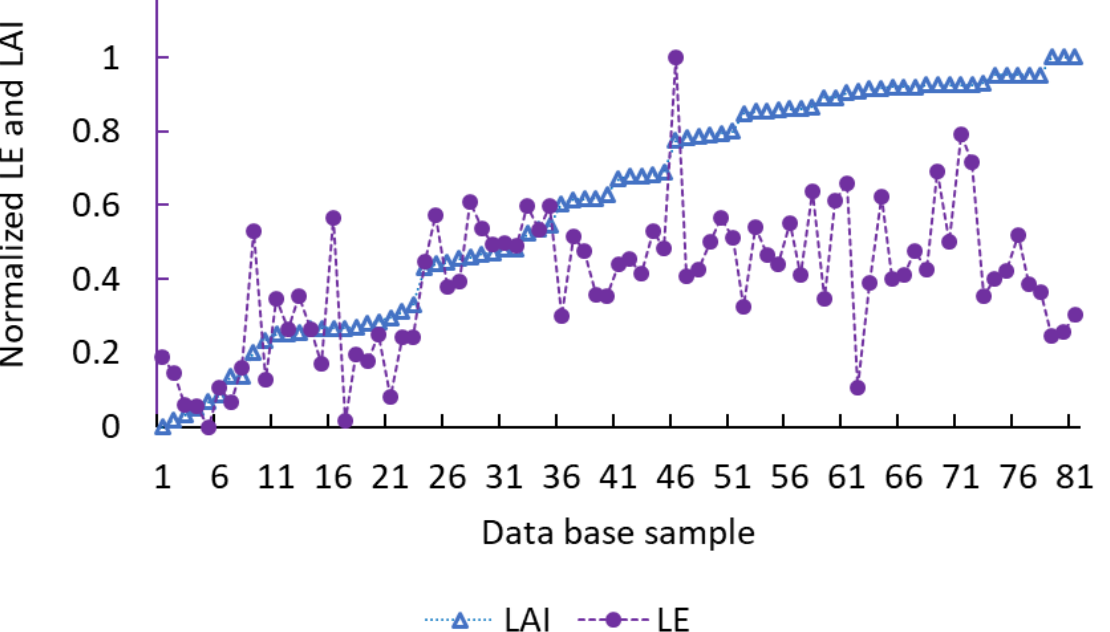
Figure 8. Seasonal time course of normalized LAI and LE at data points during the 2017 season (the X-axis) when all other meteorological variables were the same (within a narrow range). Values were normalized relative to their maximum during the season.